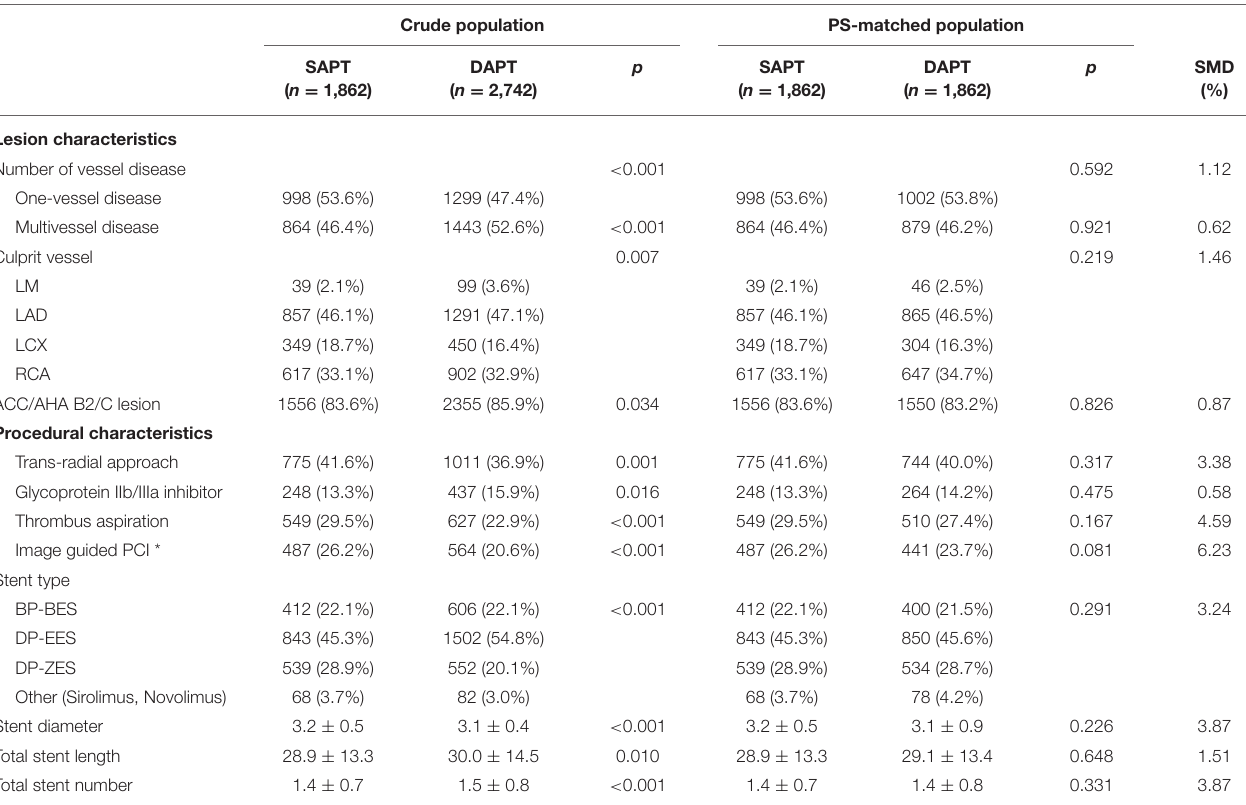
TABLE 2 | Lesion and procedural characteristics of the study